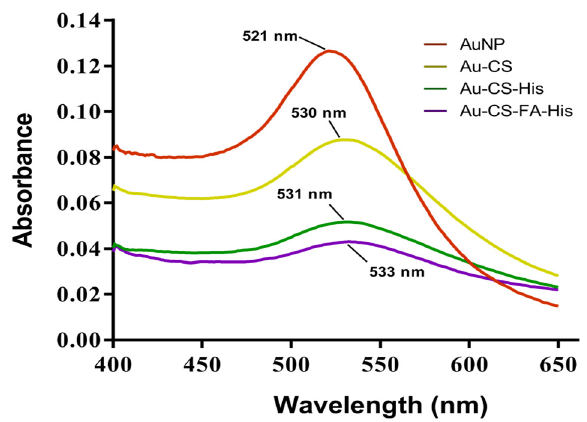
Figure 1. UV–Vis spectrum of AuNPs and FAuNPs.